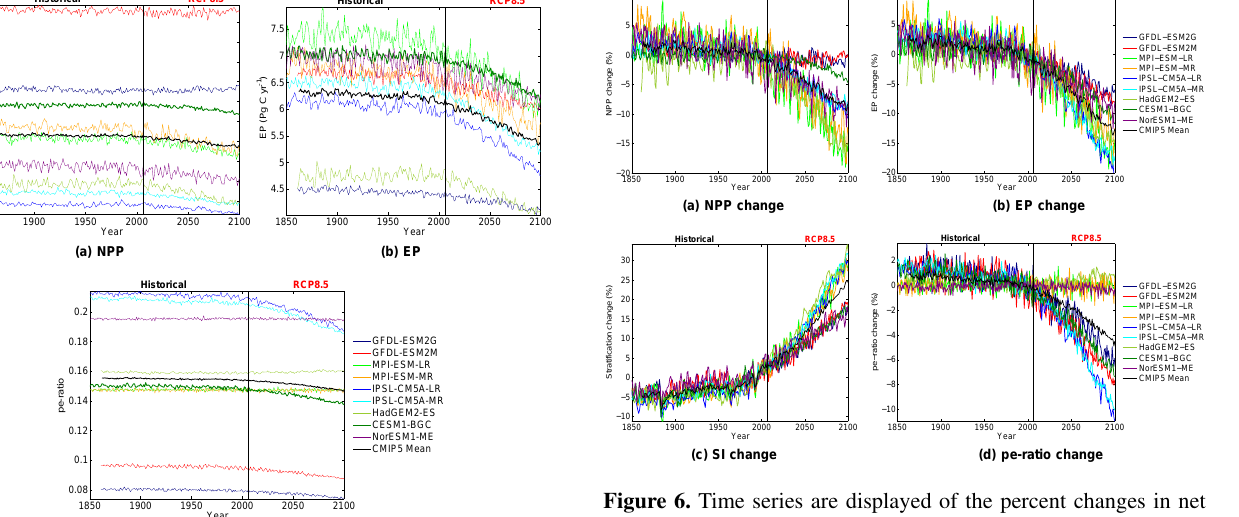
Figure 6. Time series are displayed of the percent changes in net primary production, export production and the particle export ratio and stratification over the period 1850–2100 (each relative to their 1990s